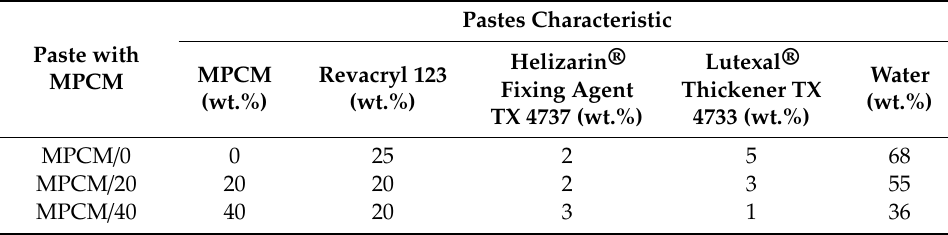
Table 3. Characteristics of polymer pastes.